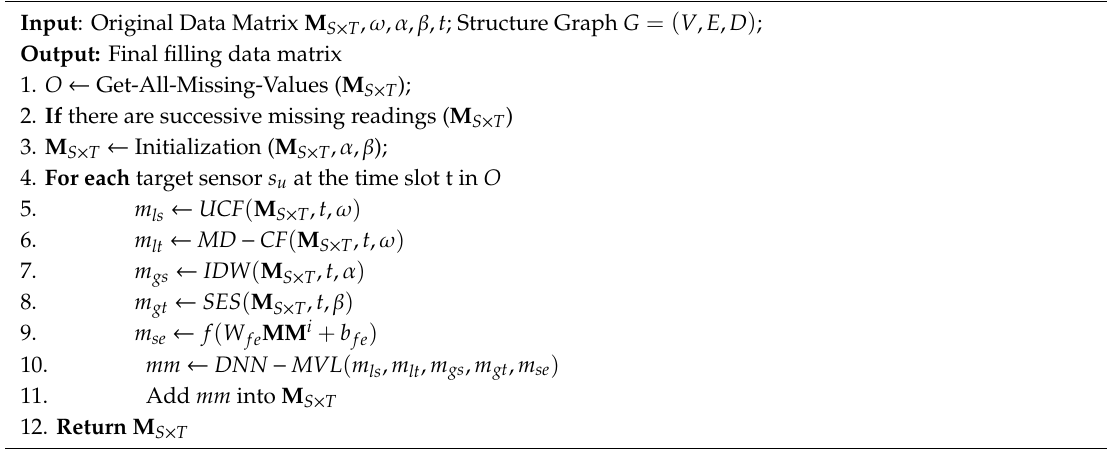
Algorithm 1: DNN_ multi-view learning method (MVL).